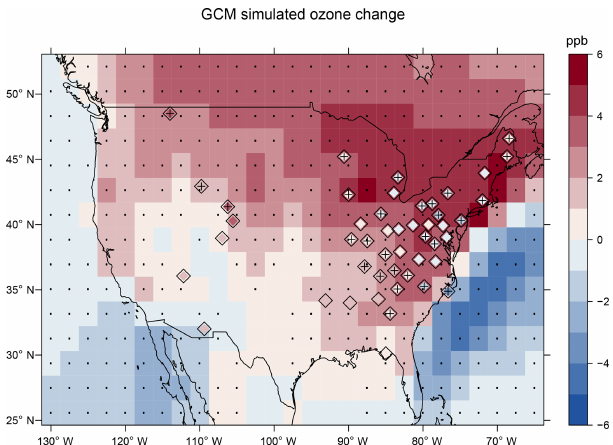
Figure 10. JJA change in MDA8 ozone between the GCM2100 simulation and the GCM2000 simulation (ppb, shaded). Diamonds give the change in MDA8 ozone in the linear regression model de- rived from the measurements using the AWA difference (between GCM2100 and GCM2000) projection as the explanatory